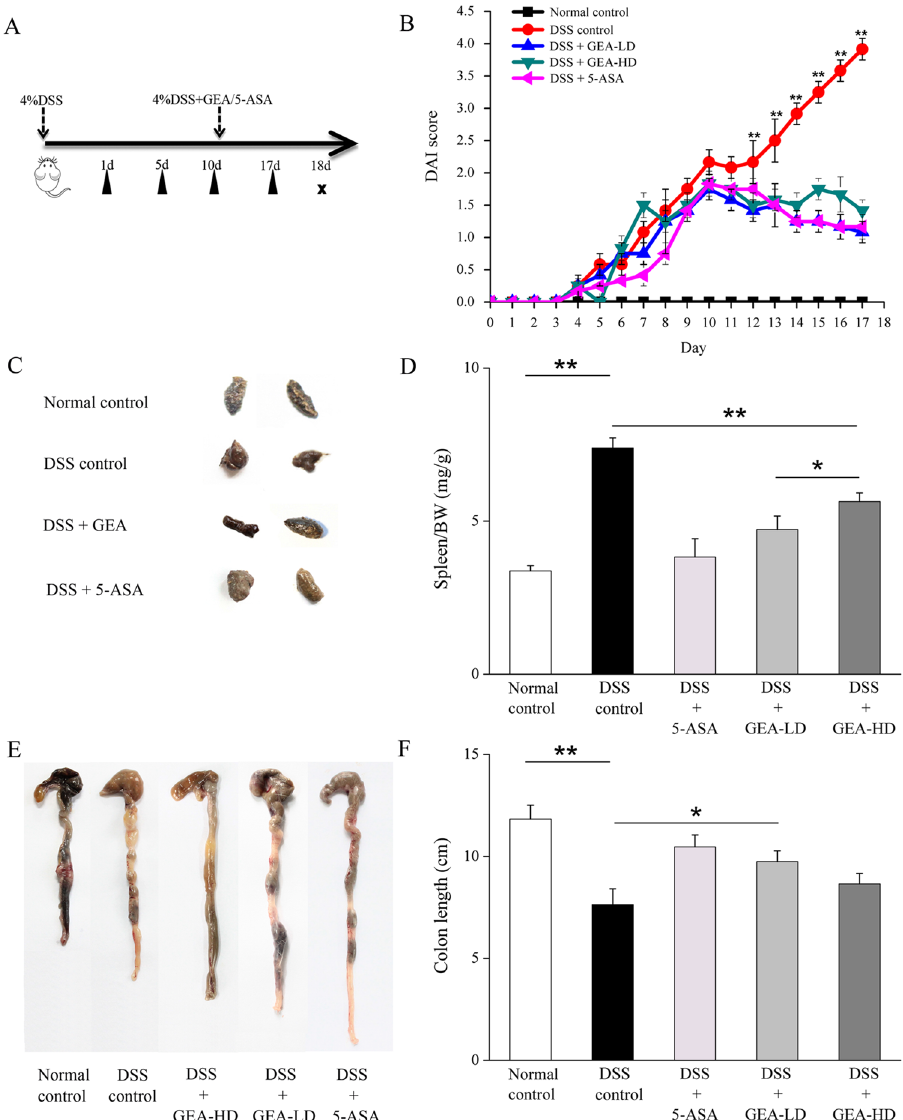
Figure 8. Turkish galls inhibits DSS-induced UC in mice. ( A ) Methods for DSS-induced colitis. ( B ) DAI was measured daily. ( C ) Representative photographs of feces. ( D ) Spleen/BW ratio was determined at the end of the experimental period. ( E ) Representative photographs of colon. ( F ) On day 17 of the experiments, the colon was removed, and the length was measured. The values are expressed as the mean ± S.D. * P < 0.05, ** P < 0.01, *** P <